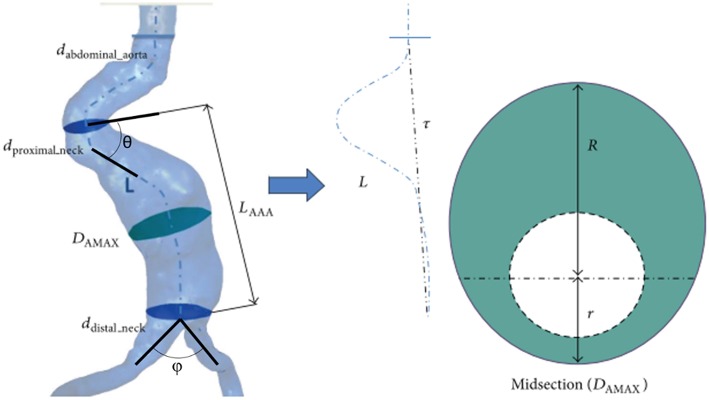
Main geometric parameters for a patient-specific AAA geometry. LAAA, Aneurysm length; DAMAX, Maximum aneurysm diameter; dproximal_neck, Inlet diameter of AAA sac; ddistal_neck, Outlet diameter of AAA sac; dabdominal_aorta, Normal abdominal aorta diameter; θ, Proximal neck angle; ϕ, Iliac bifurcation angle; L, Absolute length of tortuous vessel; τ, Imaginary straight line starting at the center of normal abdominal aorta and ending at the iliac bifurcation. The midsection at the location of the maximum AAA diameter (DAMAX) is represented at the right side. At the maximum diameter midsection, r and R are the radii measured from center of the undilated portion (i.e., normal abdominal aorta) to the posterior and anterior walls, respectively [The figure is adapted from Soudah et al. (2013) and used with permission].